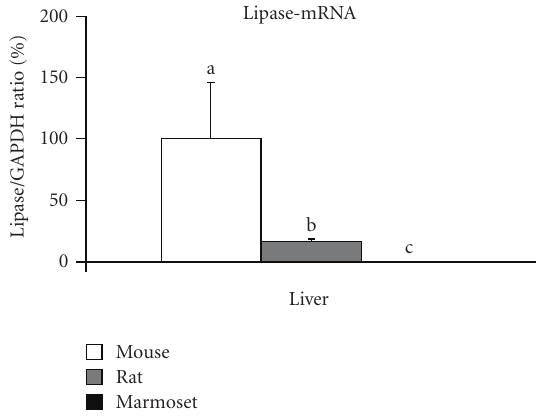
Figure 2: Lipase-mRNA levels in mice, rats, and marmosets. Each mRNA level was measured by real-time quantitative PCR and normalized to the GAPDH-mRNA level in the same preparation. Mouse liver mean was assigned a value of 100. Figures represent mean ± SD from 6 from mice and 5 from rats and marmosets. Comparisons were made using analysis of variance and the Tukey- Kramer HSD post hoc test. Di ff erent letters (a, b, c) on the top of each bar in each organ indicate that they are significantly di ff erent from each other ( P <